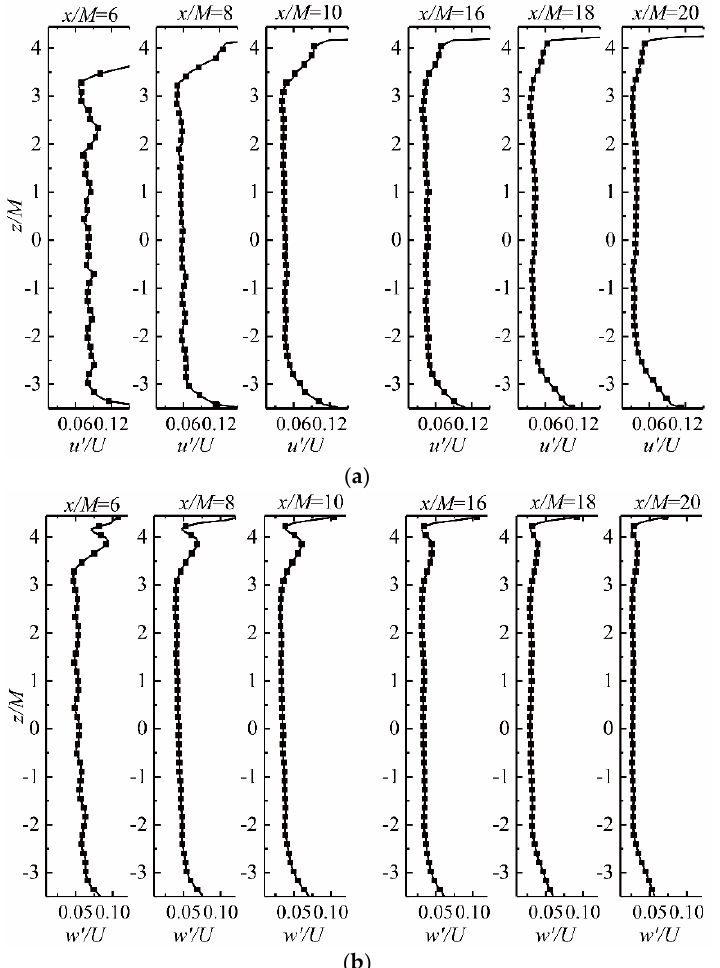
Figure 11. Vertical distribution of turbulence intensities ( a ) stream-wise components ( u’ / U ); ( b ) vertical components ( w’ / U ) at mid-span of channel.